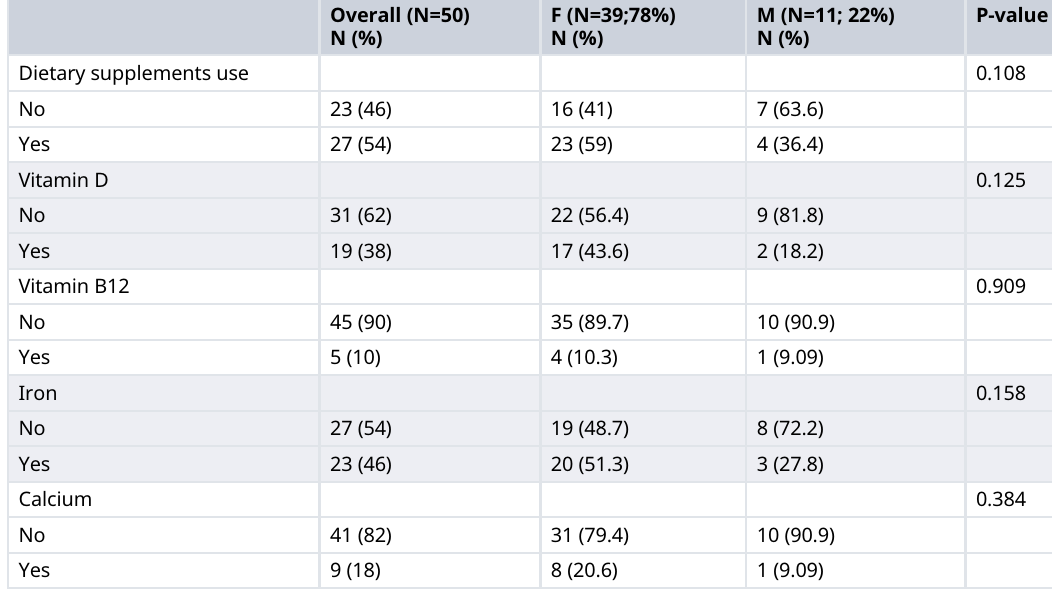
Table 6. Supplements intake among study participants, by age group, by gender and reference to recommended daily allowance RDA for each element. Overall (N=50) N